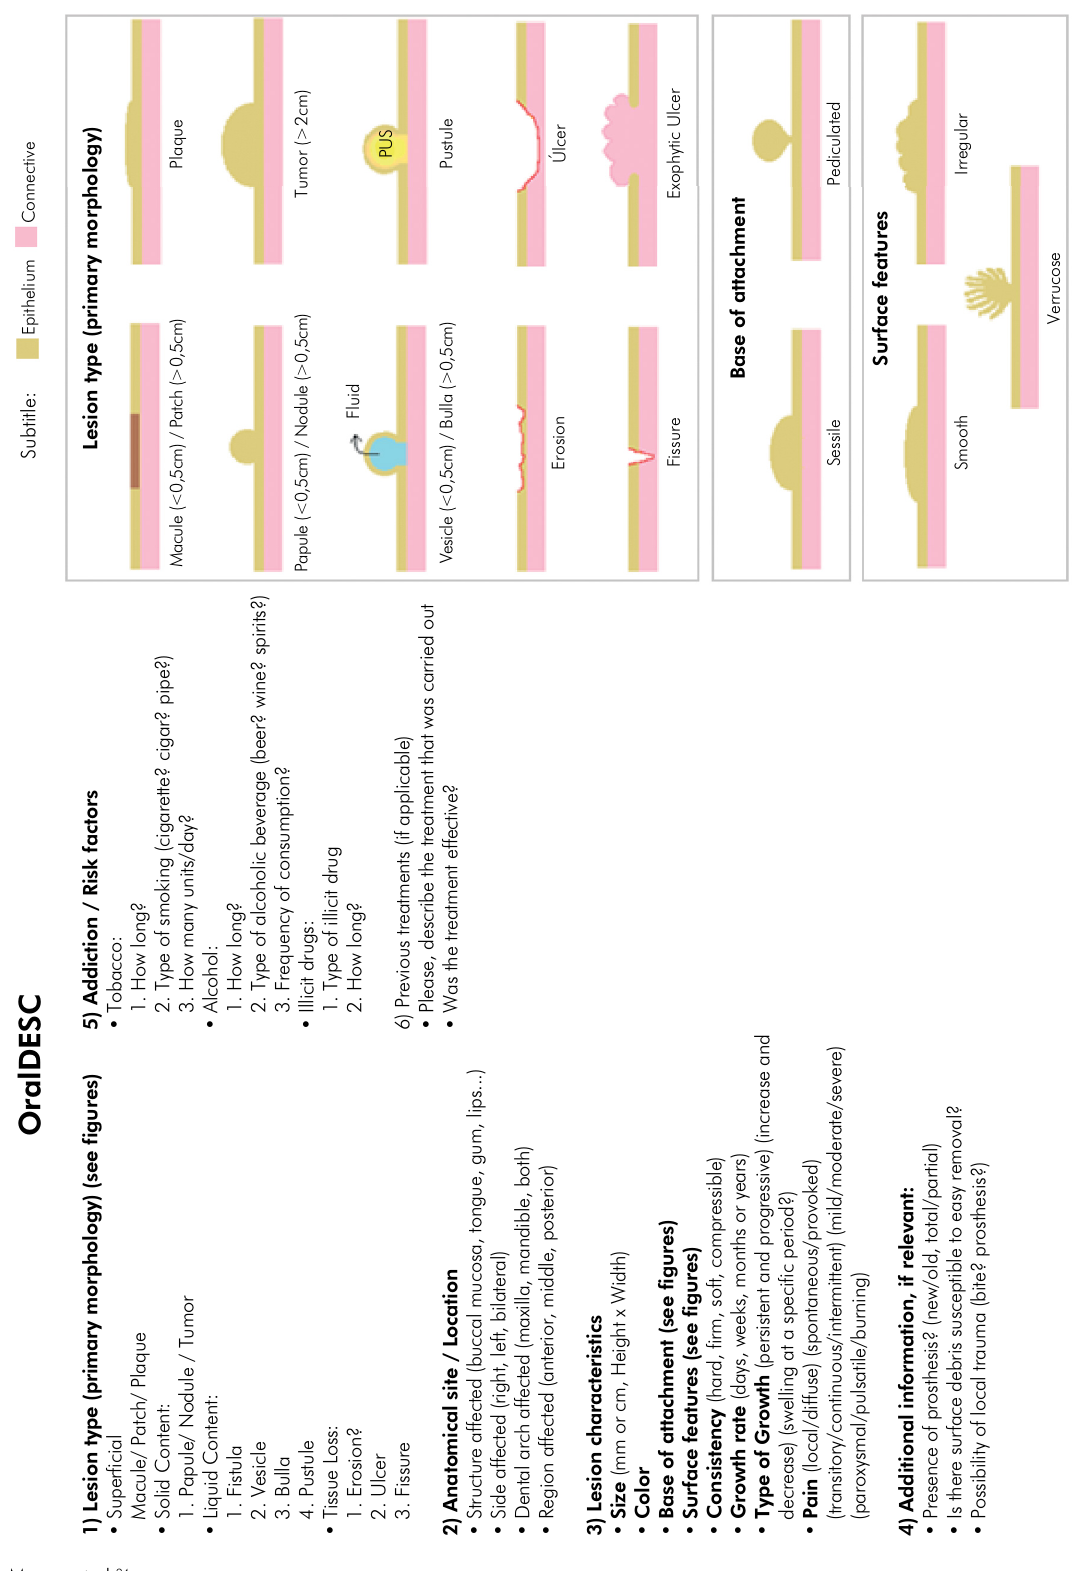
Figure 2. OralDESC guideline: items for oral lesion description and corresponding